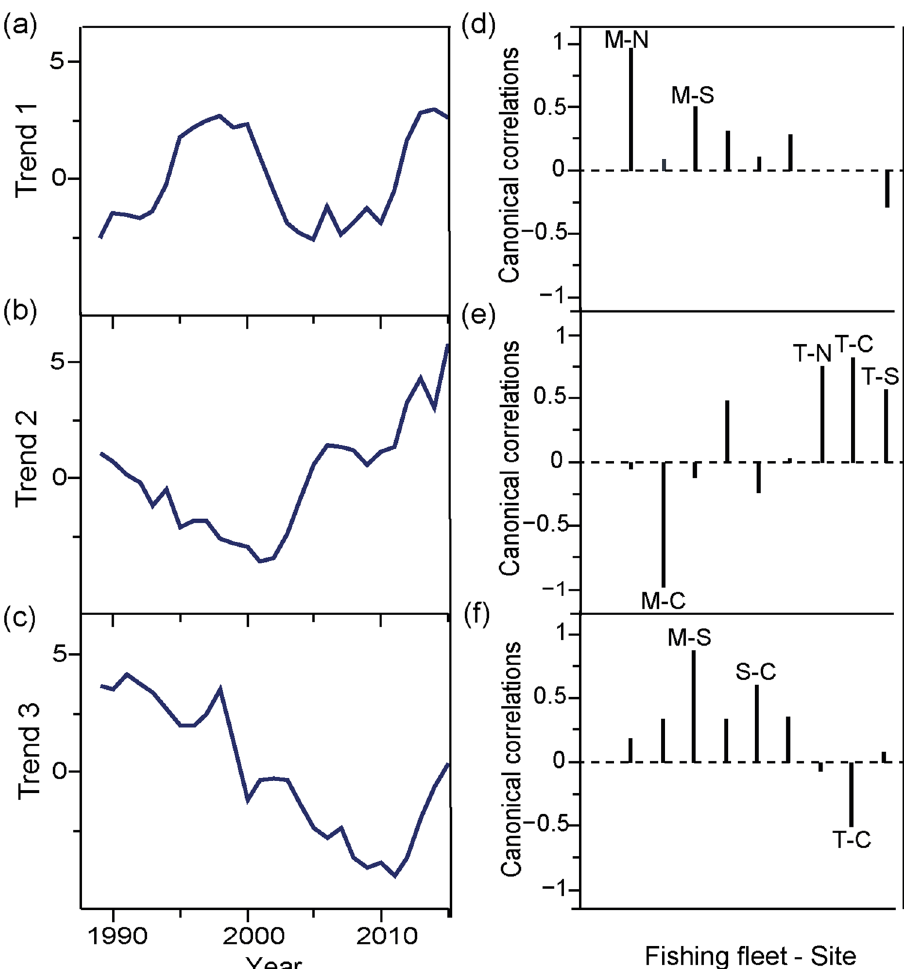
Figure 3. Common trends (left; a , b , c ) and the corresponding canonical correlations (right; d , e , f ) for the ecological sensitivity of the landings (ESL) series obtained by the model containing three common trends. Common trends are unitless. Labelled correlations correspond to the significant correlations (> 0.5). The first letter of the abbreviation corresponds to the fishing fleet (M = Multi-gear; S = purse-Seine; T = Trawling) and the second letter to the area (N = North; C = Centre; S =